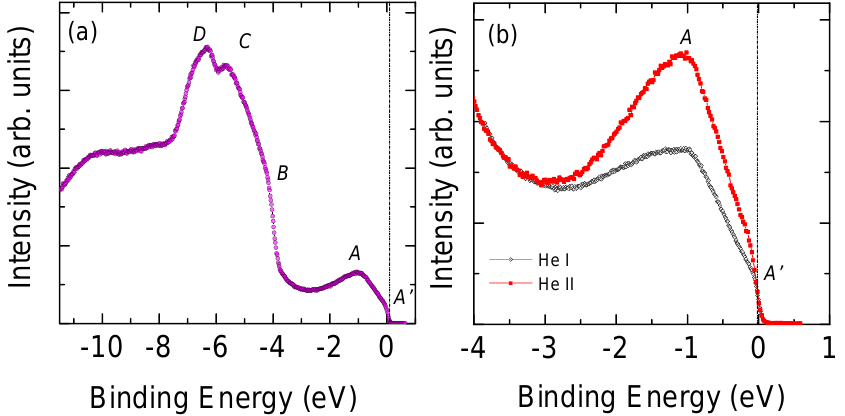
Figure 6. ( a ) The valence band spectra of Sm 3 Co 4 Ge 13 taken using He II (40.8 eV) source. The dashed vertical line corresponds to the Fermi level. ( b ) The near E F valence band spectrum for Sm 3 Co 4 Ge 13 taken using He I (21.2 eV) and He II (40.8 eV) source. The dashed vertical line corresponds to the Fermi